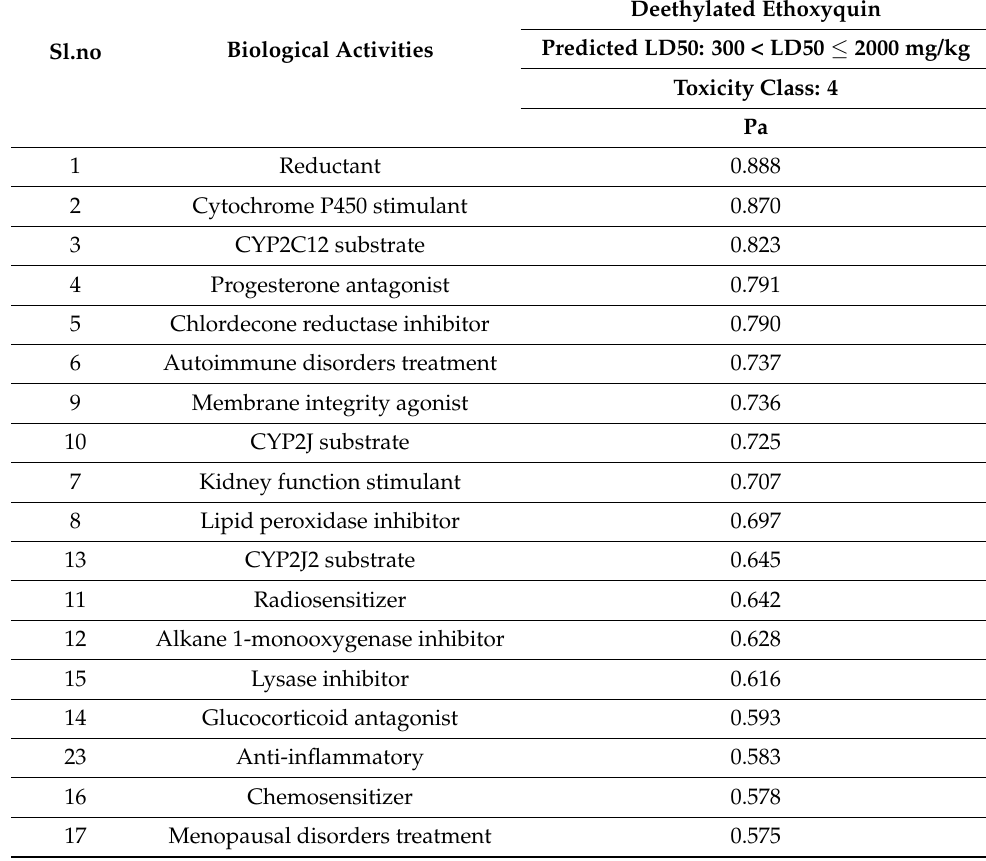
Table 1. The results of the prediction of biological activity spectra for substances (PASS) prediction study of the biological activities of deethylated ethoxyquin